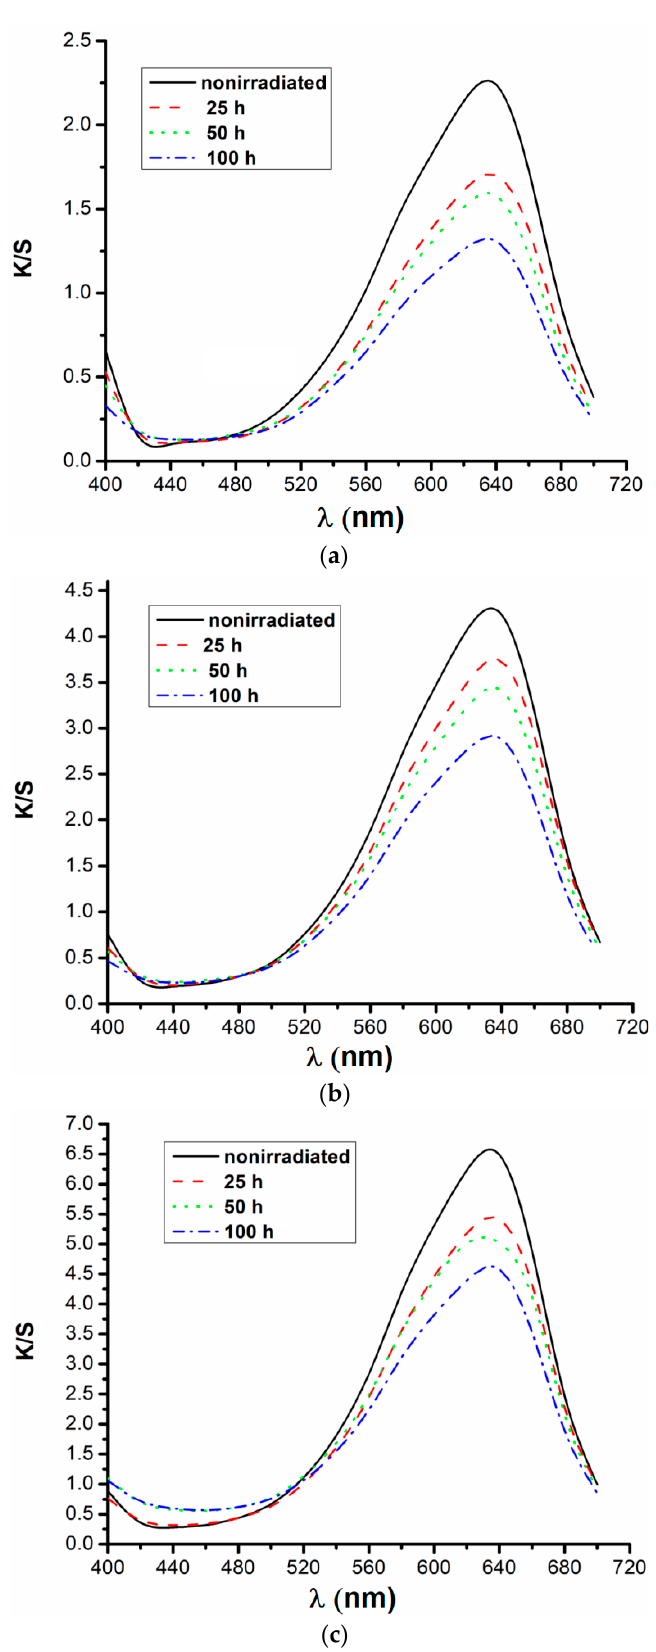
Figure 5 . Color intensity for samples dyed with RB_204 and irradiated: ( a ) 1%, ( b ) 3%, ( c ) 5% dye . Table 3 . Color intensity and discoloration degree of samples dyed with 1%, 3%, and 5% solution of reactive dye as a function of irradiation time irradiated in UV, measured at 636 nm. Irradiation Time K/S Values Concentration